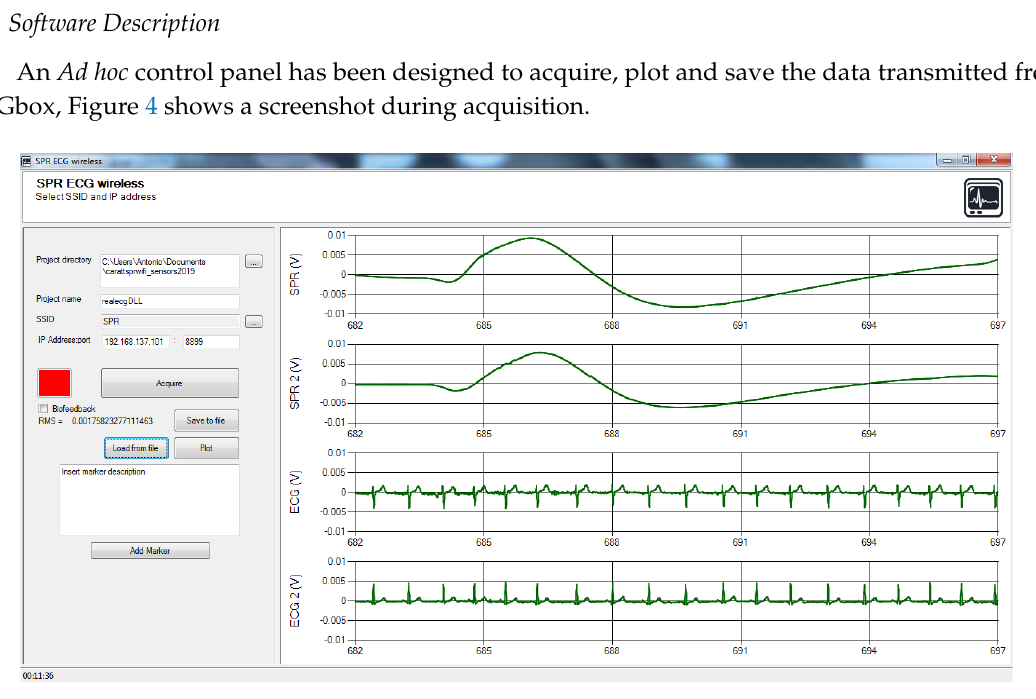
Figure 4. Control panel developed in .NET environment for data acquisition and real time plot; upper traces show SPR channels, bottom traces show ECG